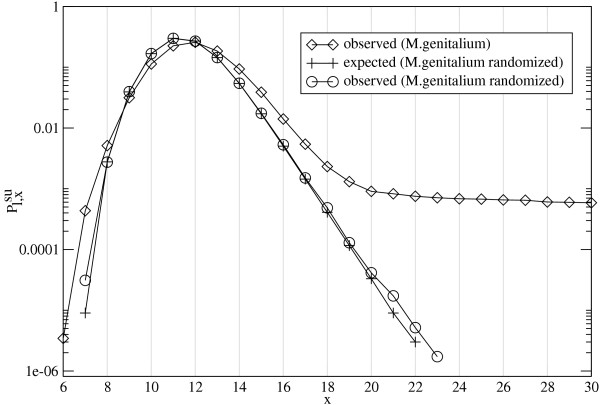
Shustring probability distribution in the randomized genome of Mycoplasma genitalium. Observed and expected distributions of the lengths x of local shortest unique substrings. The "observed" distribution was obtained by shuffling the nucleotides of the genome of Mycoplasma genitalium (c. f. Figure 2), while the expected distribution is based on equation (1) using the genome's GC-content of 2p = 0.316 and length l = 580,074 bp.